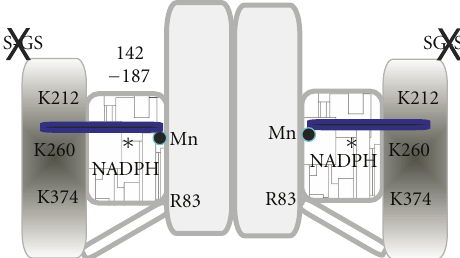
Figure 1: Main domains of the mitochondrial isocitrate dehy- drogenase, IDH2.The homodimeric IDH2 of two 413-amino acid subunits; each 47 kDa subunit is schematically illustrated according the solved crystal structure of porcine IDH2 [50]. Residues 142–187 make up two stacked four-stranded antiparallel β -sheets (middle white marble-shaded domain). Mn 2+ and isocitrate in the active site are depicted as a blue circle and rod, respectively. Six Arg residues, which provide hydrogen bonds with isocitrate oxygens [50], are not depicted. Arg 83 (R83) interacts by hydrogen bonding with the 3 (cid:3) - OH of the nicotinamide ribose and thus enhances NADP + a ffi nity [53]. An Arg residue corresponding to human Arg172, which is often mutated in gliomas and AML, is indicated by an asterisk ( ∗ ). For activity, the glutathionylation of Cys269 [46] (GS–S) must be removed (X) by reactivation aided by glutaredoxin-2 in the presence of reduced glutathionine, and the protein must be deacetylated by SIRT3 [44]. We hypothesize that Lys212, Lys374, and Lys260 (in porcine notation) are the prime candidates for acetylation causing IDH2